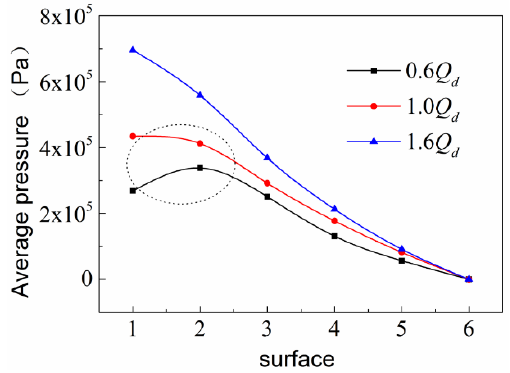
Figure 15. Average pressure of monitoring surfaces.